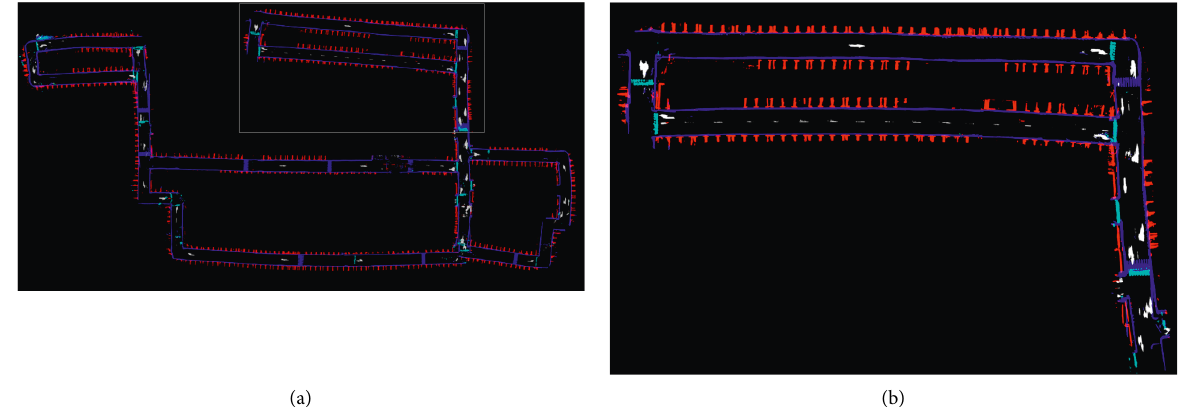
Figure 9: Optimized semantic map. (a) Global view. (b) Zoom-in